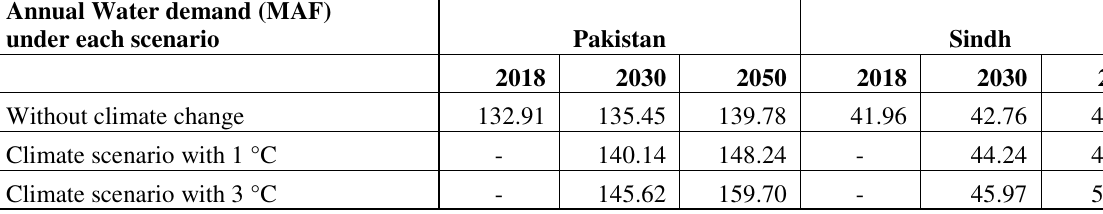
Table 5: Industrial Water Demand in Pakistan and Sindh Annual Water demand (MAF) under each scenario Without climate